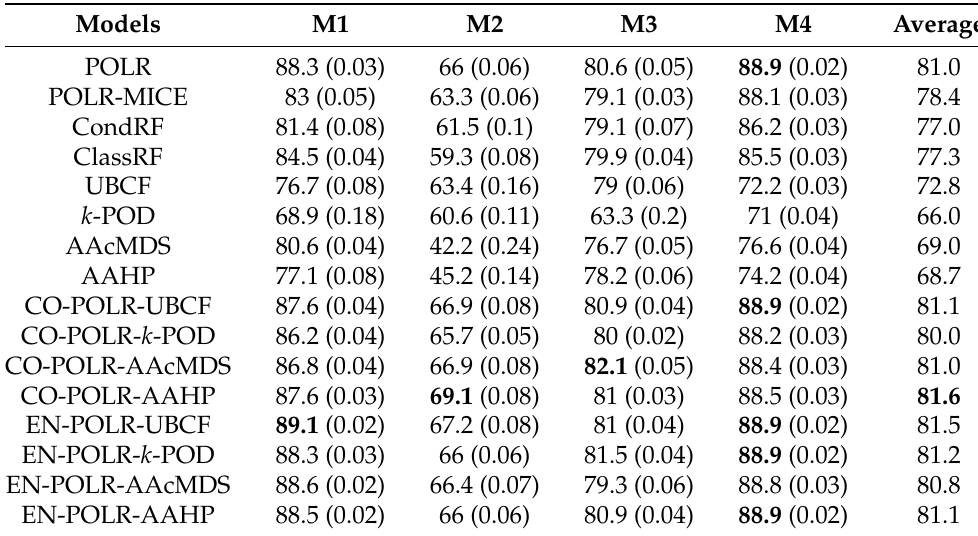
Table 3. Mean and standard deviation, in brackets, of accuracy (percentage) over 10 simulations of the classifiers for the different models of Scenario 1 and their average. The maximum value in each column appears in